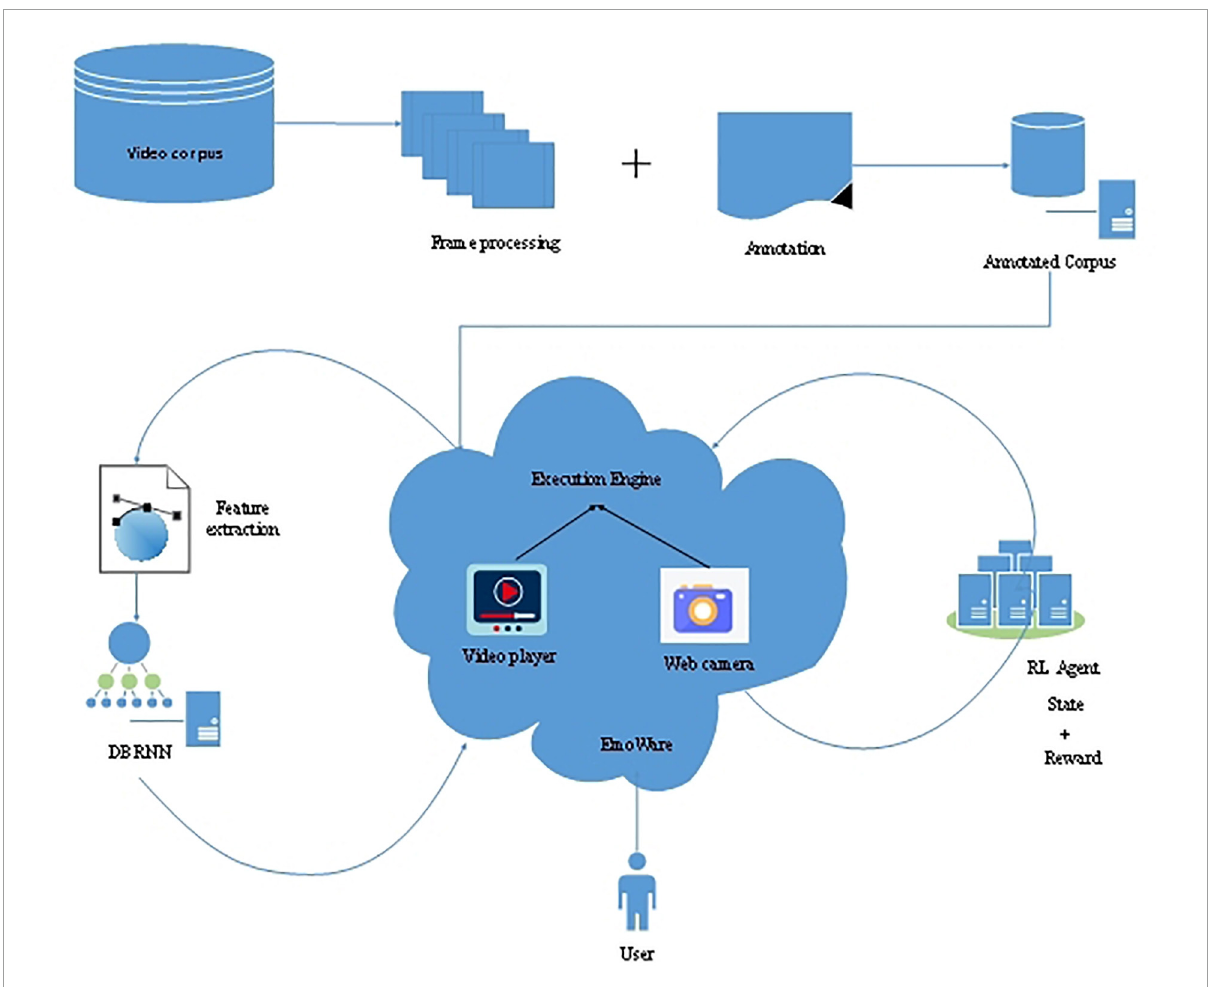
FIGURE9 The framework of EmoWare (Tripathi et al., 2019).